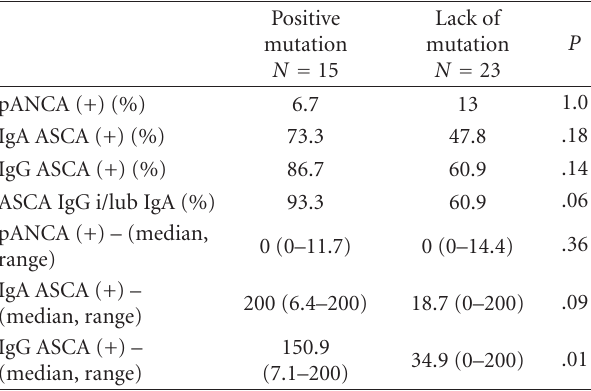
Table 4: The presence and titre of p-ANCA and ASCA in relation to the occurrence of R702W/G908/L1007fs mutation in Crohn’s